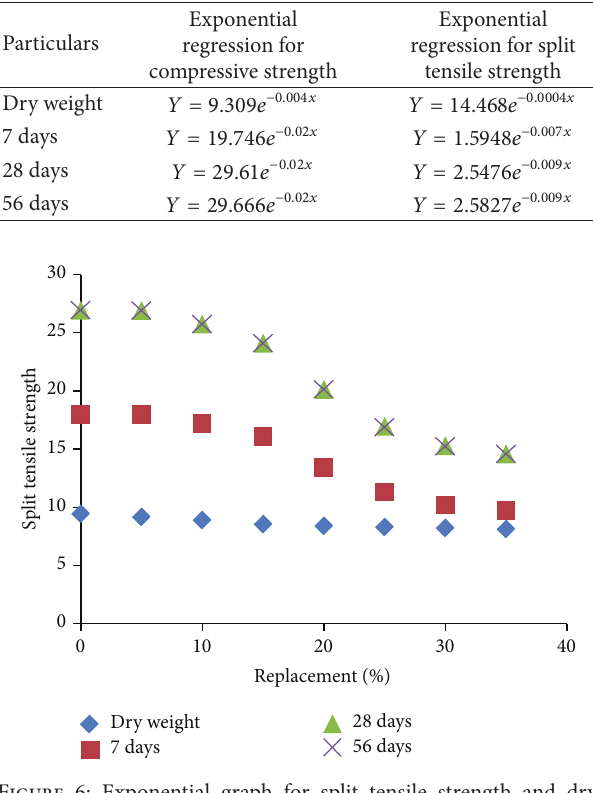
Table 2: Regression equation for compressive and tensile strength.